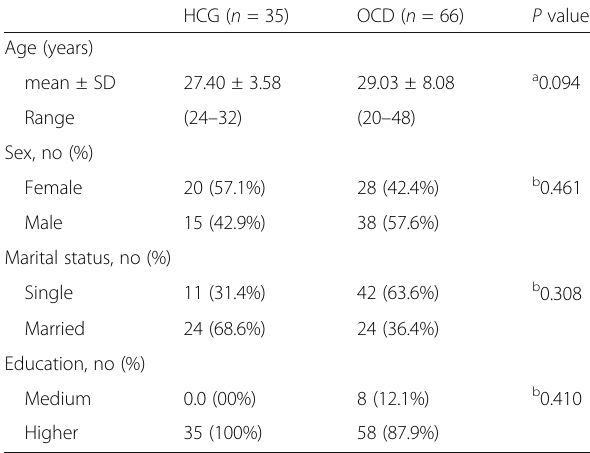
Table 1 Demographic characteristics of the studied participants